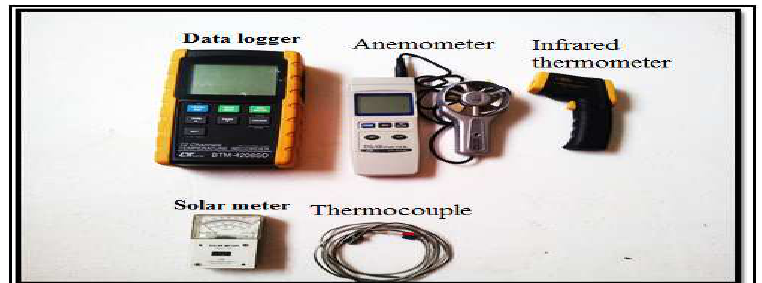
Fig. 8. Photographic view of